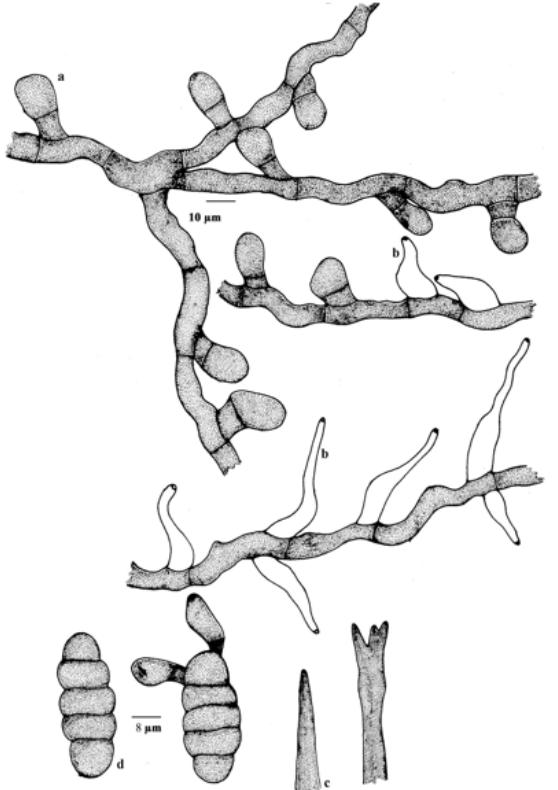
Figure-71. Meliola dysoxyligena a - Appressorium; b - Phialide; c - Apical portion of mycelial setae; d -